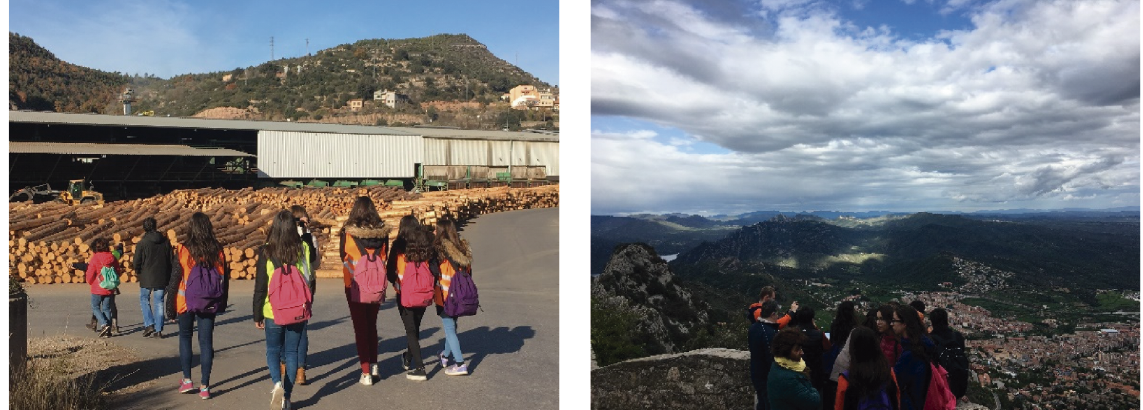
Figure 11. Some images from learning